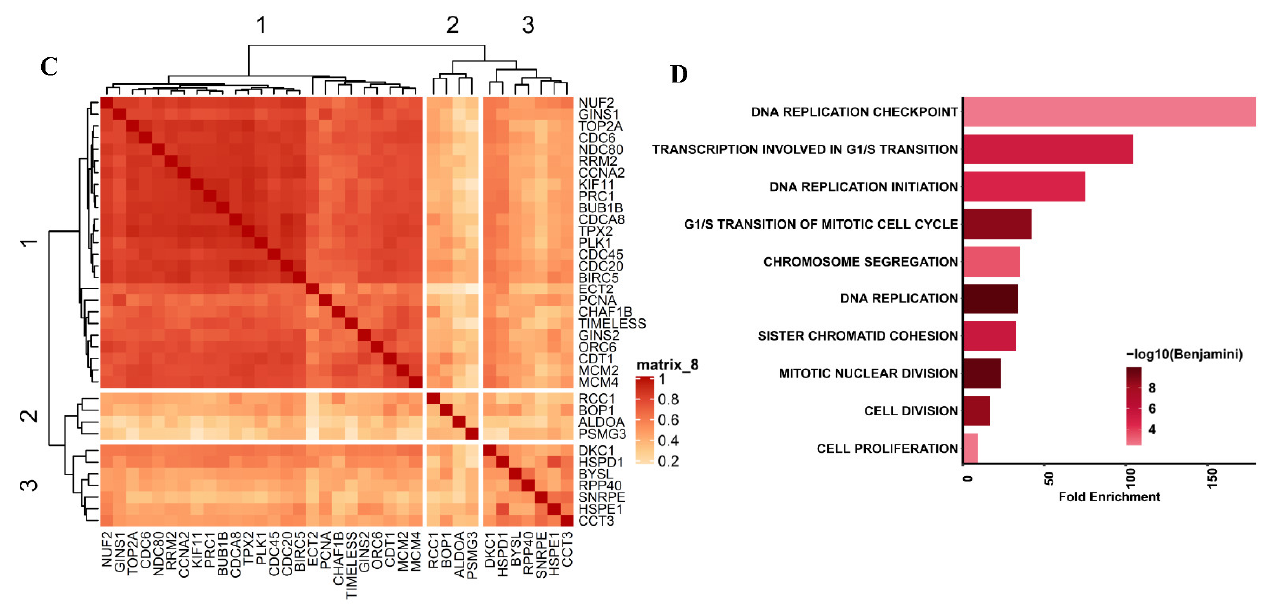
Figure 1. Identification of cancer essential genes in lung adenocarcinoma (LUAD). ( A ) Flowchart demonstrating our investi- gation of the clinical importance and molecular associations among LUAD essential gene-stratified clusters. ( B ) Heatmap showing significantly upregulated genes in LUAD tumor tissues compared to paired normal tissues using RNA sequencing data of TCGA and GSE140343. The horizontal bar plot represents the median CERES score in LUAD cells from Project Achilles. ( C ) Associations of cancer essential genes from TCGA data are shown as a correlation heatmap. ( D ) Horizontal bar plot demonstrating the top essential gene-enriched signaling pathways using pathway enrichment analyses.